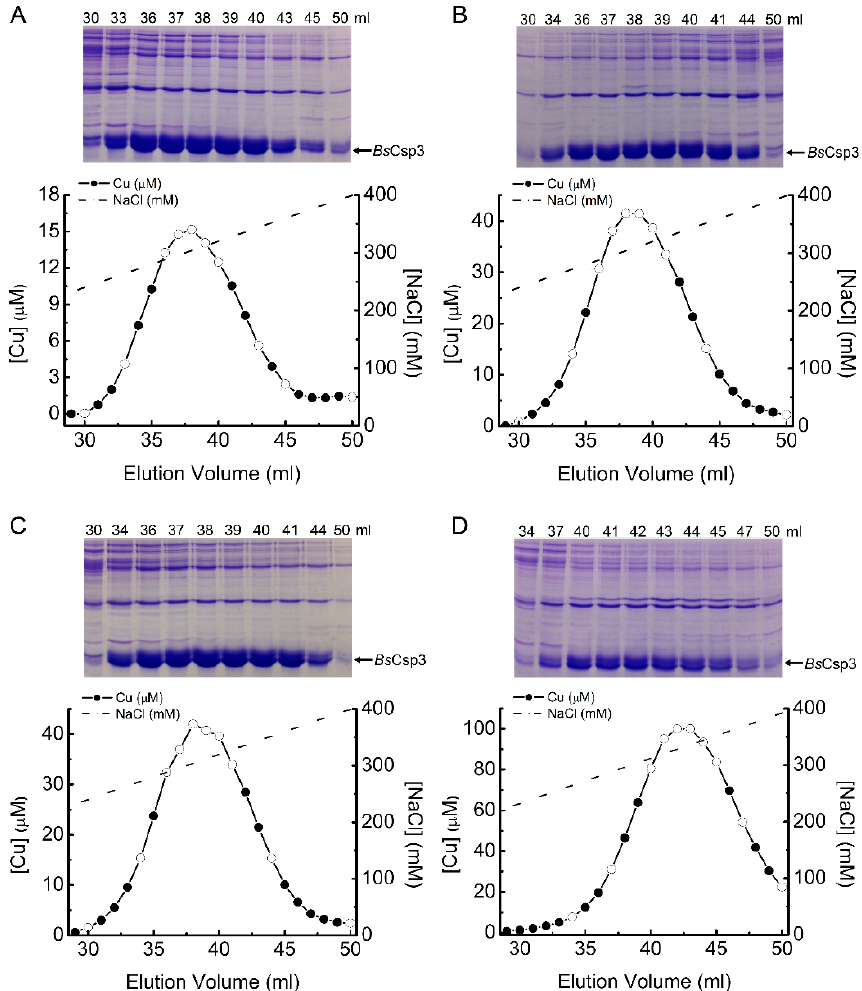
Figure 6. Comparison of Cu and protein contents in cell ‐ free extracts of E. coli expressing Bs Csp3. The quantification of Cu in fractions that elute between approximately 230–400 mM NaCl from a HiTrap Q anion ‐ exchange column in 20 mM Tris pH 8.0 when Bs Csp3 is purified from Δ copA E. coli grown in 1.0 ( A ) and 1.5 ( B ) mM Cu(NO 3 ) 2 , and from WT E. coli grown in 1.5 ( C ) and 3.4 ( D ) mM Cu(NO 3 ) 2 are shown. Those fractions whose Cu concentration is indicated with open circles were analyzed by SDS ‐ PAGE, with the elution volume above the lane.